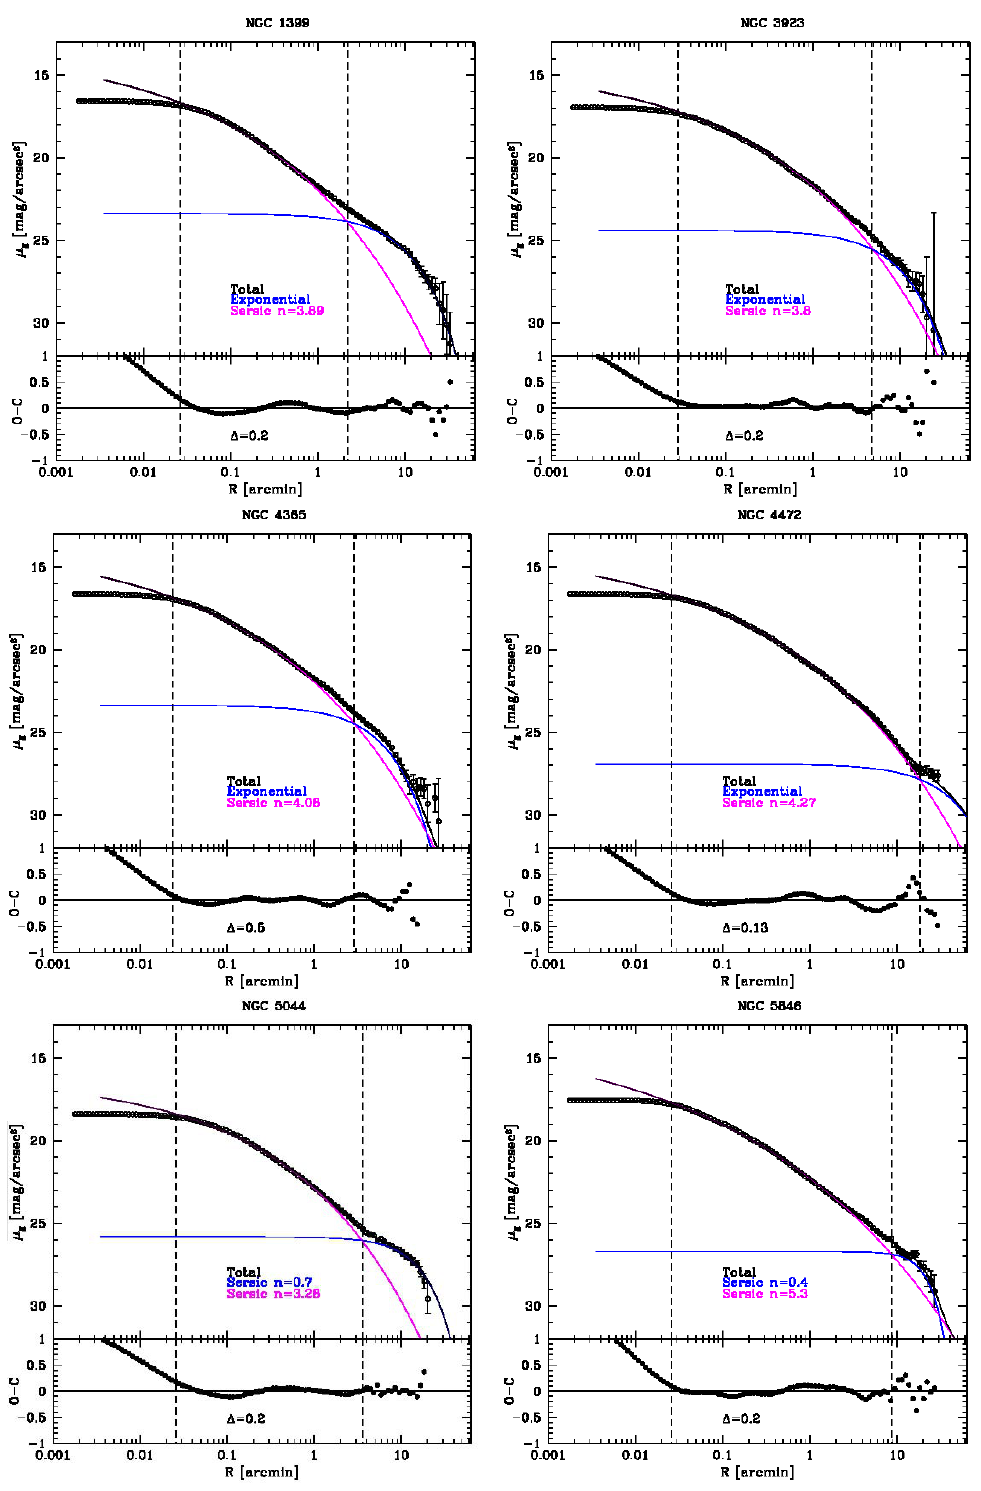
Figure 1. VST g -band profiles of NGC 1399, NGC 3923, NGC 4365, NGC 4472, NGC 5044, and NGC 5846 plotted on a logarithmic scale. The blue line is a fit to the outer regions with an exponential component, for NGC 1399, NGC 3923, NGC 4365, and NGC 4472, and with a Sérsic component for NGC 5044 and NGC 5846. The magenta line is a fit to the inner regions with a Sérsic profile, and the black line is the sum of the components in each fit. The dashed lines indicate the core of the galaxy (1.5 × FWHM ), which was excluded in the fit, and the transition point between the two components,